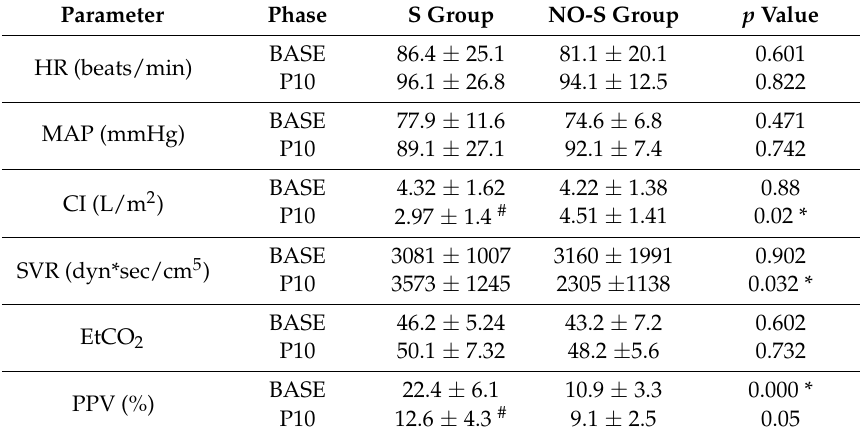
Table 3. Mean ± SD of the cardiovascular parameters evaluated in mechanically ventilated isoflurane- anesthetized dogs, 5 min before (BASE) and 10 min after (P10) the pneumoperitoneum. Based on the variation of CI after the PP, dogs were divided into the groups S (CI decreased ≥ 15%) and NO-S. The p value related to the comparison of the two groups at the same time is also reported in table. * p < 0.05 between the two groups. # p < 0.05 compared to the corresponding basal